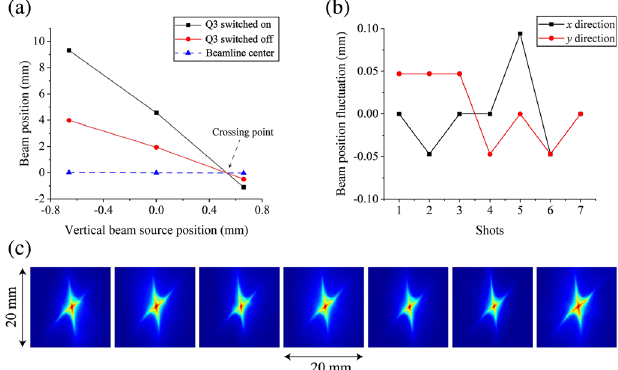
FIG. 3. Determining the displacement of the beam source and fluctuations of the beam spot. (a) By moving the beam source up and down 0.66 mm in the y direction, beam spot positions (black and red dots) at BPD#1 show remarkable variations, and beam line center c (blue dots) can be obtained. The coordinate origin of the x axis is the initial position of the beam source. The coordinate origin of the y axis is determined by the average beam line centers c at BPD#1. The crossing point indicates the real beam source position (0.53 mm on the x axis). (b) Fluctua- tions of beam spot center measured on BPD#1. Positions of the beam center are converted from pixel values. (c) Seven beam spots measured on BPD#1.